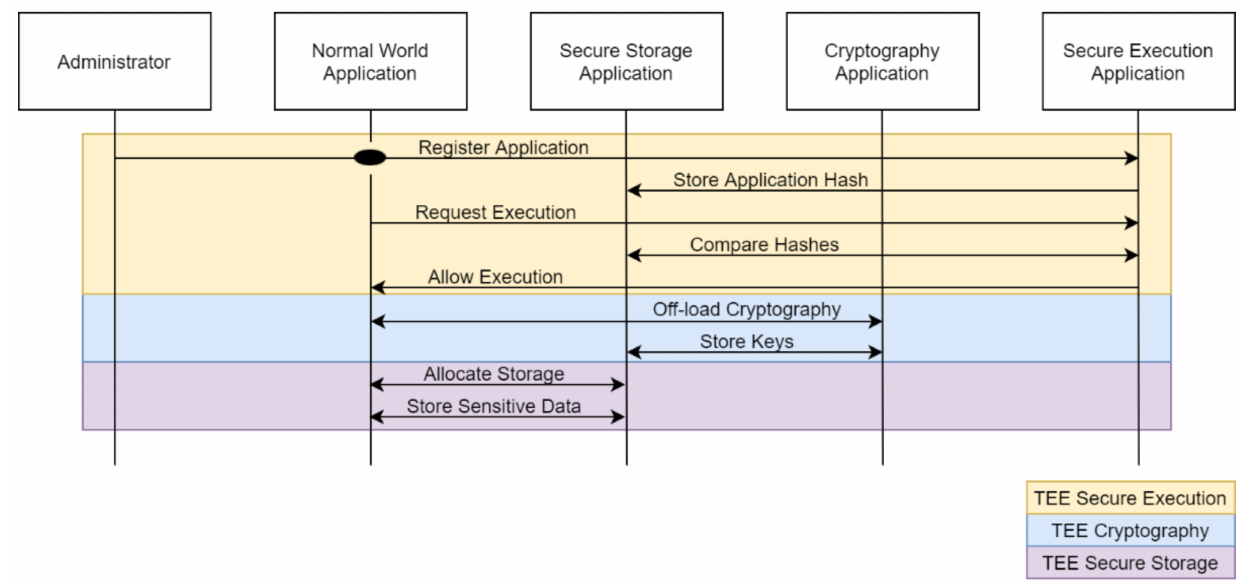
Figure 8. Basic use case of the full TEE functionality—secure execution, cryptography and secure